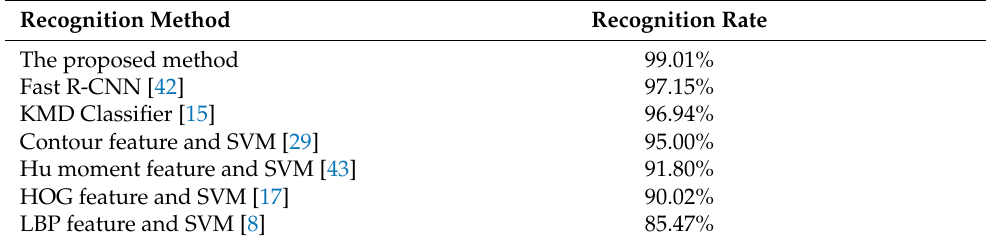
Table 4. Comparison results on self-collected dataset.